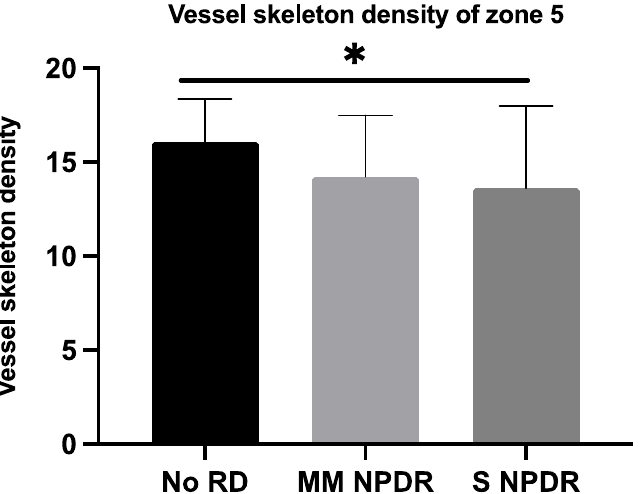
Figure 5. Mean vessel skeleton density with standard deviation for each group (without DR, mild and moderate NPDR, and severe NPDR) in zone 5. * p < 0.05. DR, diabetic retinopathy; MM NPDR, mild and moderate non-proliferative diabetic retinopathy; S NPDR, severe non-proliferative diabetic retinopathy.